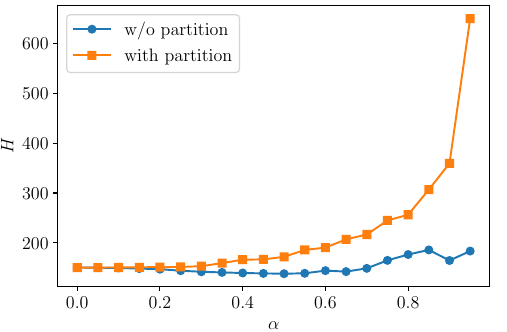
Figure 11. Time average of the objective function for the various α , where L = 8 and η = 1.0 . Orange-squares: with graph partitioning, blue-circles: without graph